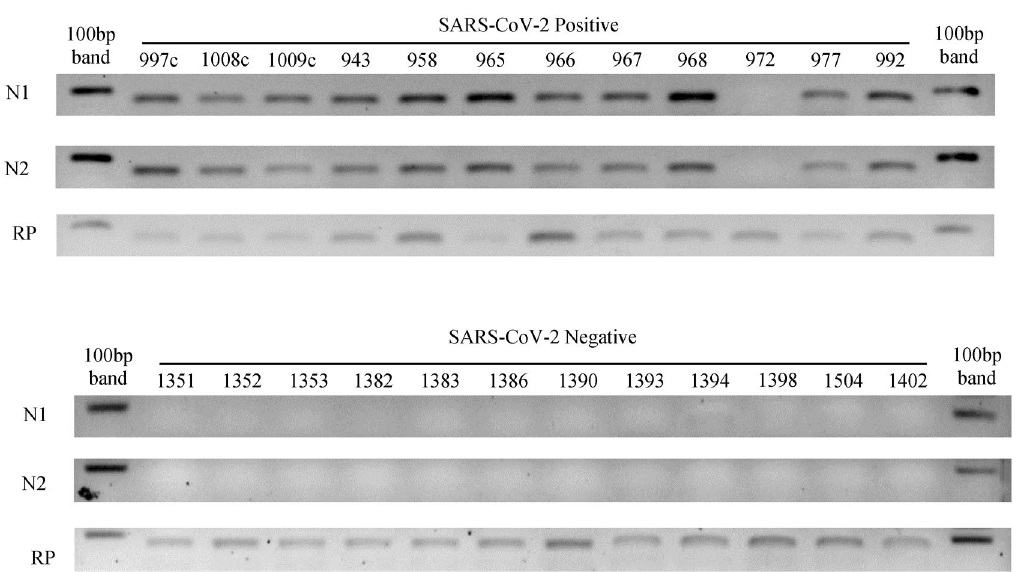
Figure 2. Agarose gel (3%) electrophoresis for SARS-CoV-2 positive and negative samples. N1 and N2 amplicons correspond with viral amplicons for CDC RT-qPCR protocol. RNase P (RP) amplicons show